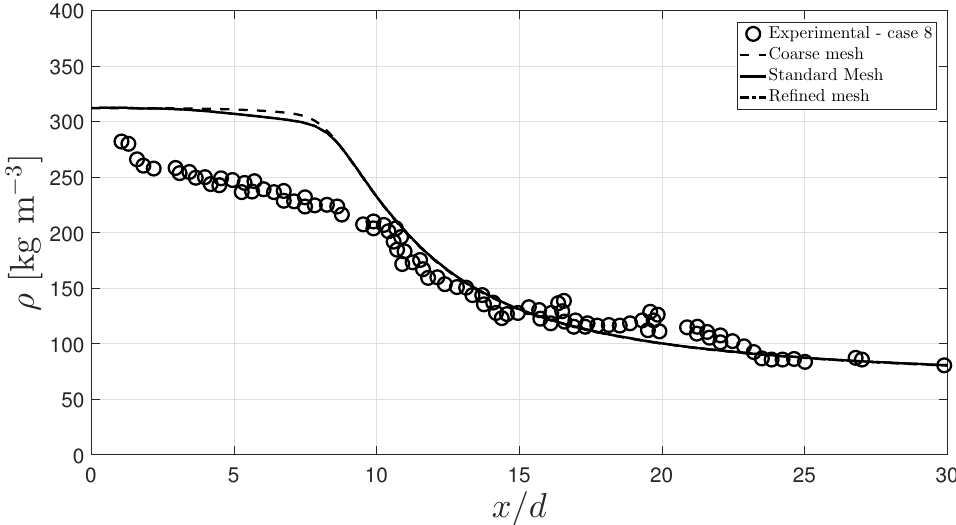
Figure 10. Axial density distribution for case 8 and comparison with experimental